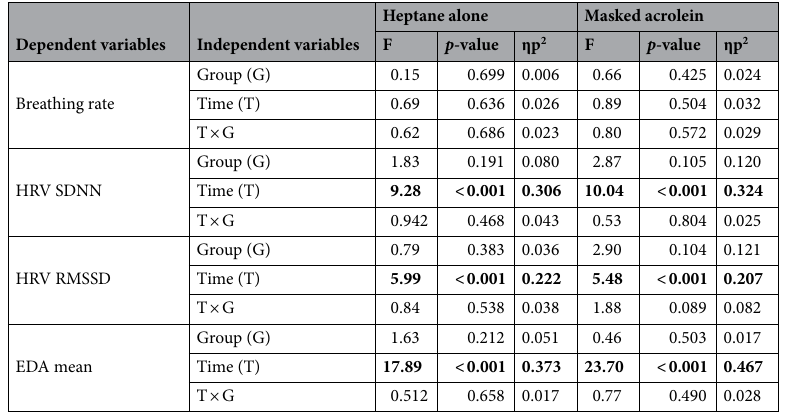
Table 3. Results from the two-way mixed ANOVAs with Time (16 measuring points) as the within-subjects variable and Group (BRS/referents) as the between-subjects variable and with measures of autonomic nervous system response as the dependent variables in the heptane alone and masked acrolein exposure conditions. Significant values are in bold.